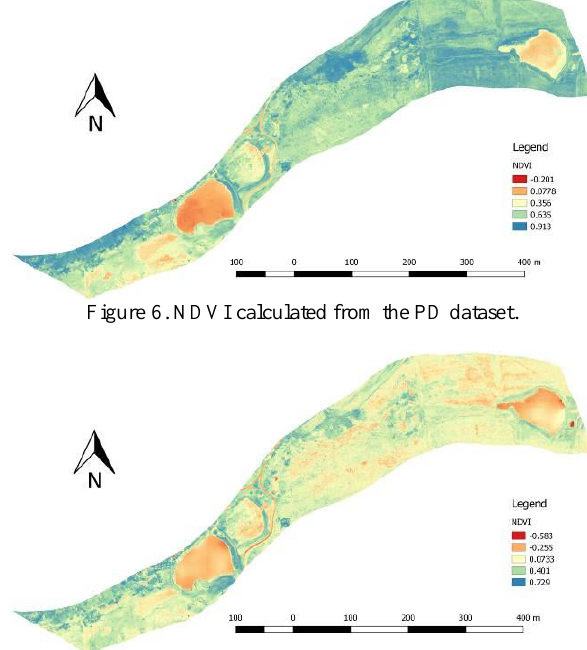
Figure 7. NDVI calculated from the PS